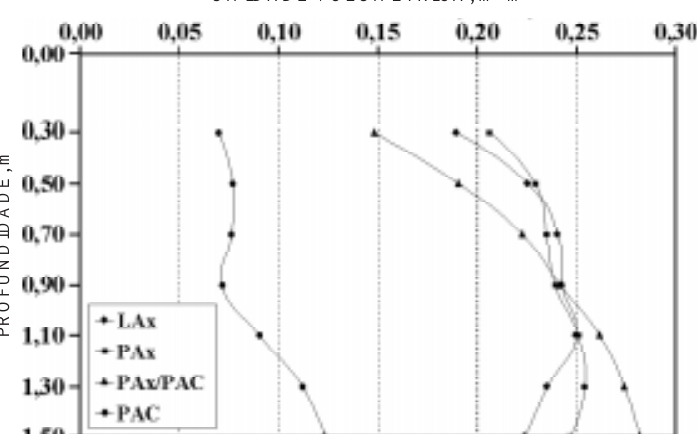
Figura 10. Variação média da umidade do solo em função da profundidade, em 53 semanas de avaliação, nos solos Latossolo Amarelo argissólico (LAx), Argissolo Amarelo (PAx), solo transicional PAx/PAC e Argissolo Acinzentado (PAC), em uma toposseqüência em tabuleiro do estado da